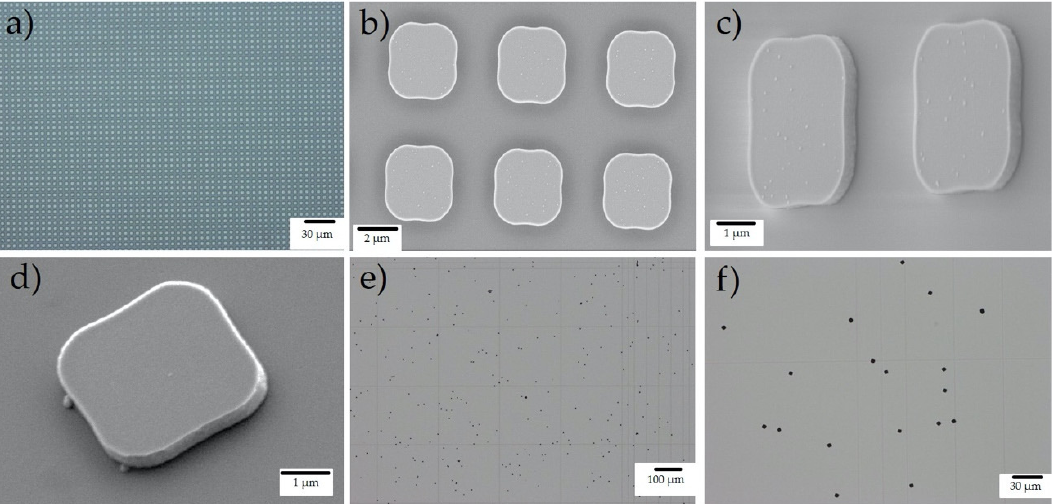
Figure 4. Images of Poly-Surfs with patterned Poly-Si μ Ps with lateral dimensions 3 × 3 μ m2 and 0.5 µ m thickness on a thermal silicon oxide layer: ( a ) Optical microscope image at scale bar of 30 µ m); ( b , c ) Scanning electron microscope (SEM) images at scale bars of 2 and 1 µ m. Images of etched and suspended Poly-Si µ Ps: ( d ) SEM image of a single Poly-Si µ P; ( e , f ) Optical microscope images at scale bar of 100 and 30 µ m,